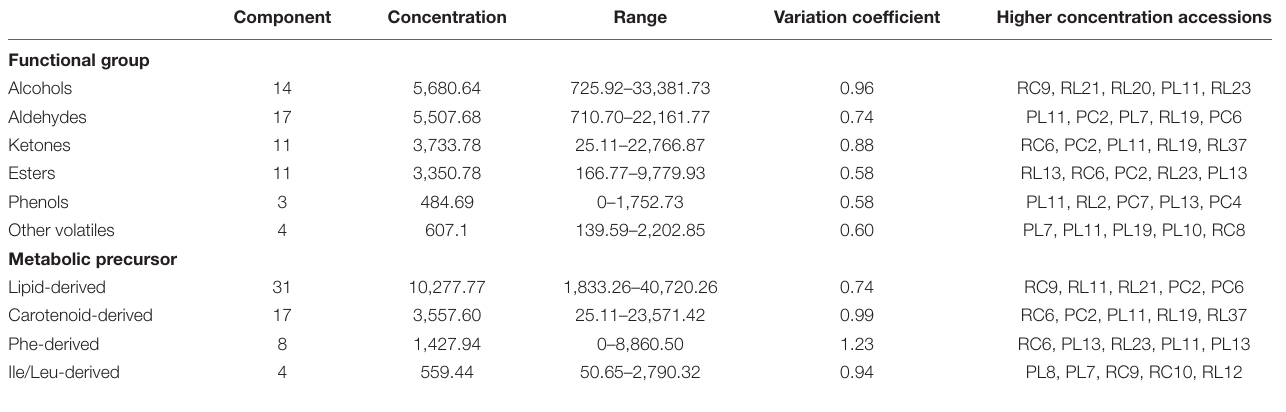
TABLE 3 | Components and concentrations (10 − 9 kg L − 1 ) of different groups of volatiles. Component